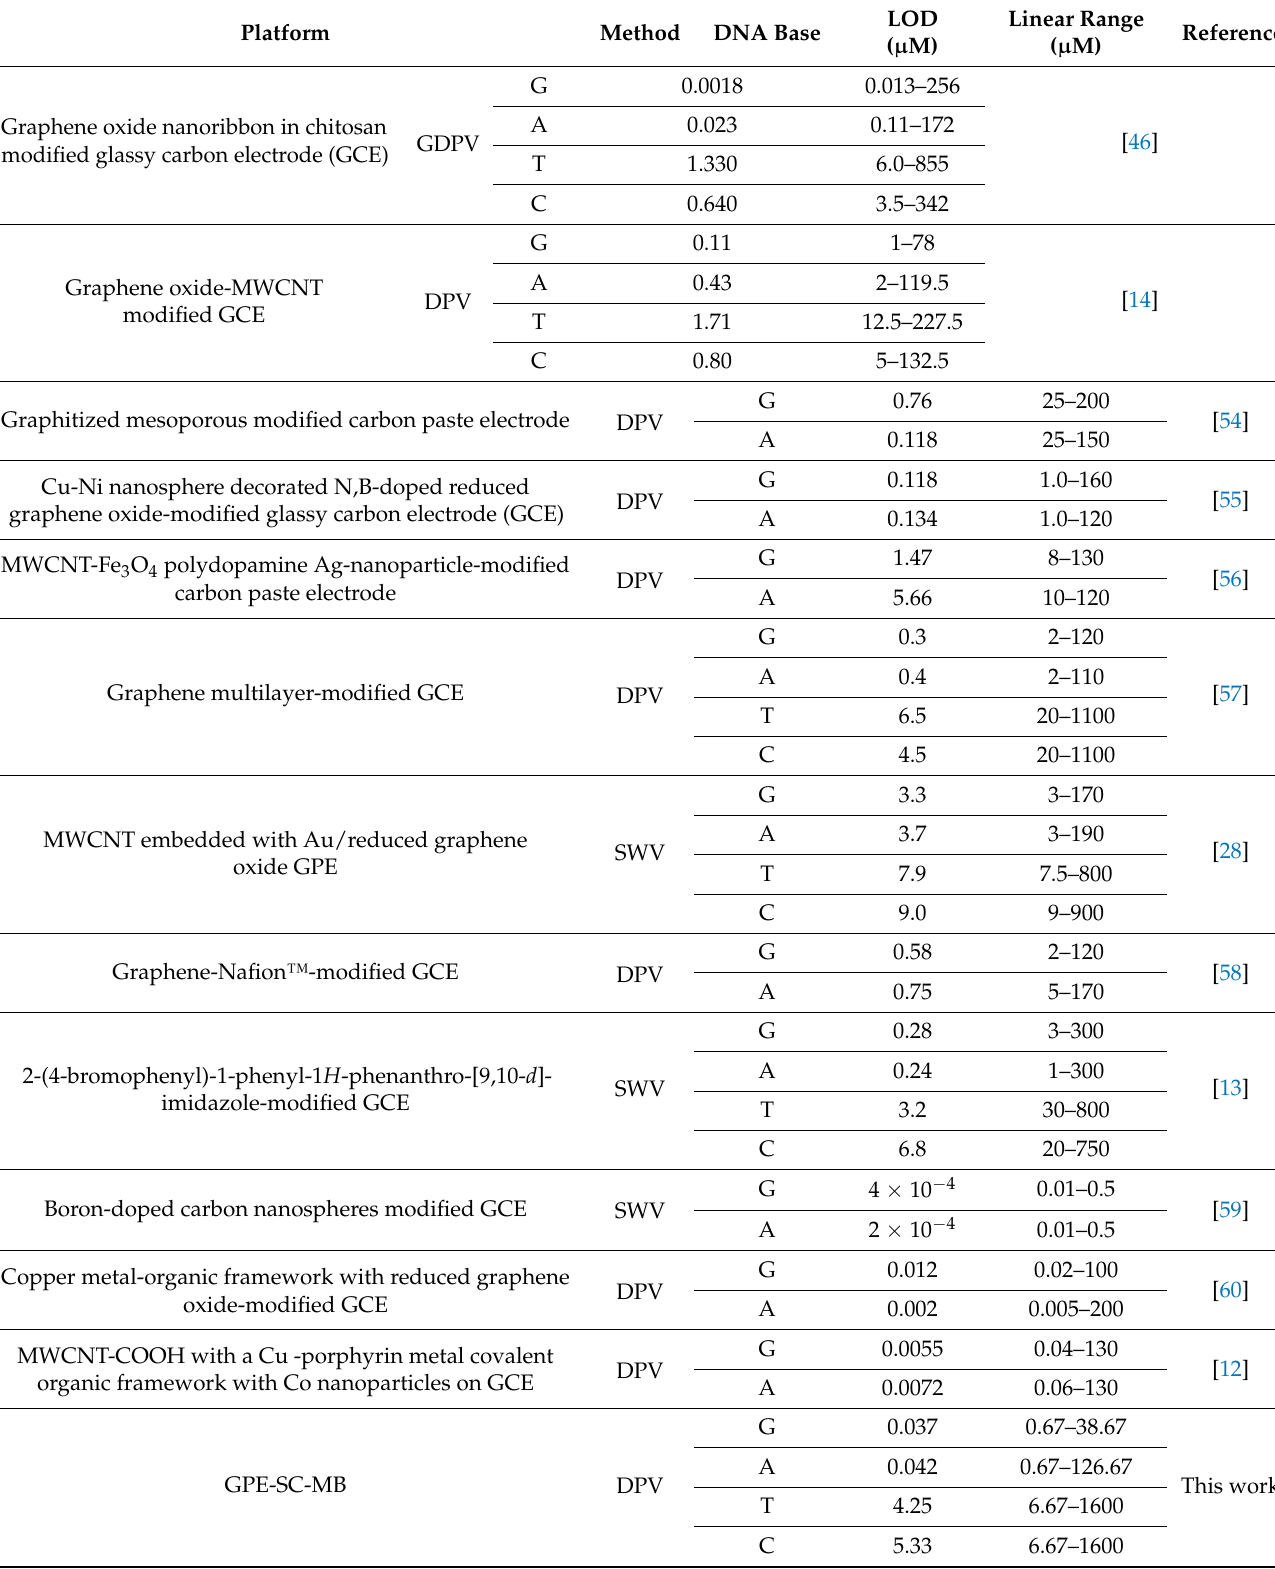
Table 3. Analytical performance comparison of this sensor with the ones reported in the